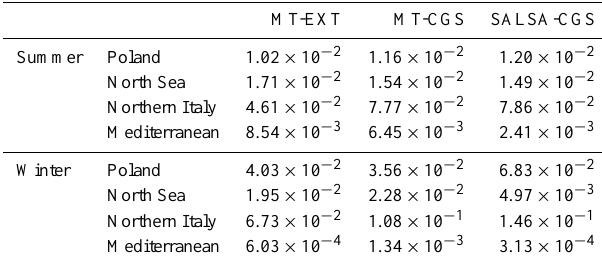
Table 6. Same as Table 5 but for black carbon